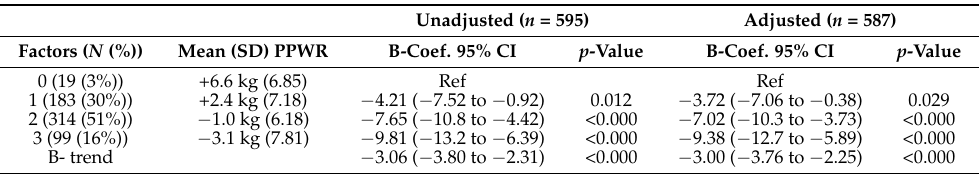
Table 3. Postpartum weight retention at 6 months in women according to the number of protective